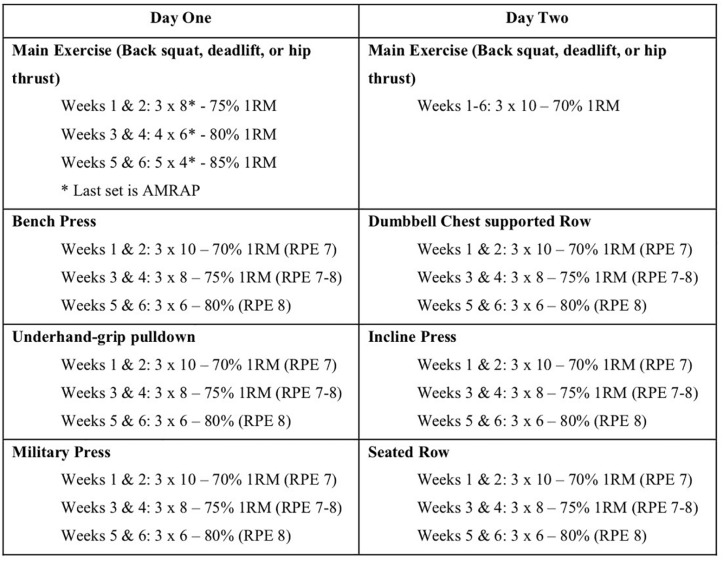
Linearized training protocol used for the 6-week intervention (weeks X, number of sets × number of reps). Participants had a 72-h break between training sessions, which were conducted at the same time each day, and provided with 40 g of whey protein supplementation. All other exercises were performed in seated position to reduce the involvement of the lower limbs (RT, resistance training; AMRAP, as many reps as possible before failure or form was compromised; RPE scale used during sessions as a training intensity guide).